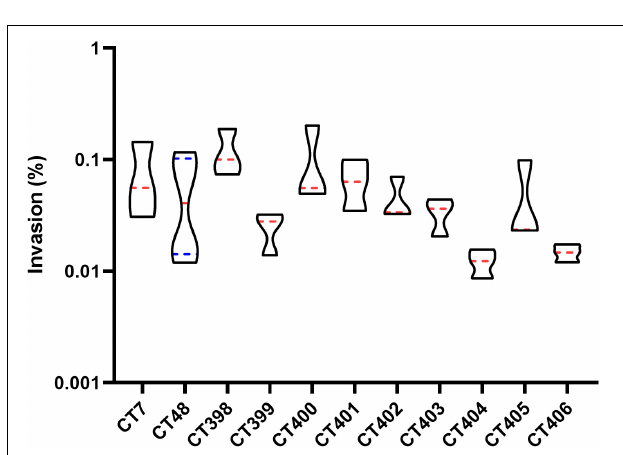
FIGURE 8 | Distribution of adhesive capacity of different CRISPR typing STEC strains. The same letter indicates that there was no significant difference between each other, and the absence of the same letter indicates that there was a significant difference between each other ( p < 0.05). The red lines represent the median, and the blue lines represent the quartile.